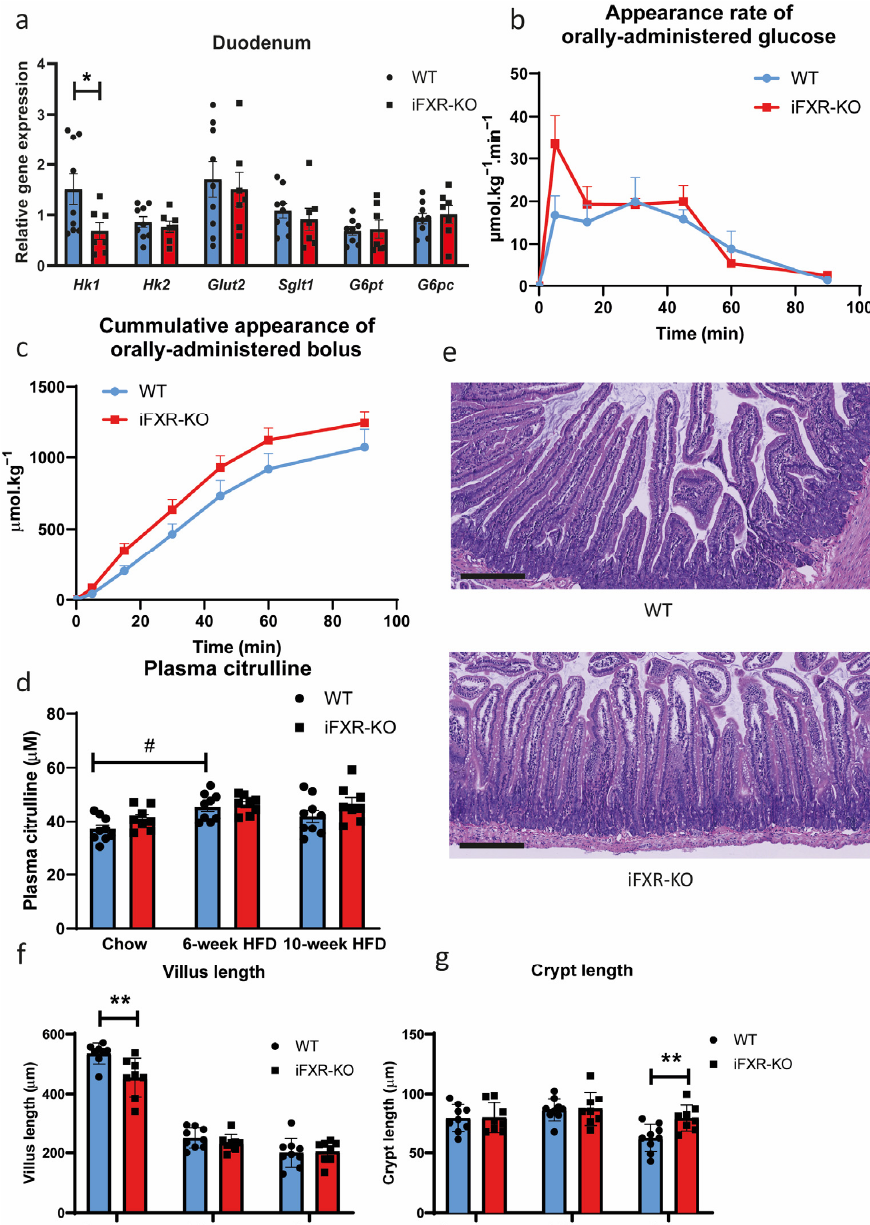
Figure 2. Long-term HFD exposure does not lead to changes of glucose absorption in iFXR-KO mice ( a ) Quantitative real-time PCR of glucose absorption gene expression in duodenum from wild-type (WT) and intestine-specific FXR − / − (iFXR-KO) mice after 10-week high-fat-diet (HFD); ( b ) Orally administrated D-[U- 13 C] glucose appearance rate and ( c ) recovery of orally administrated glucose bolus at 0, 5, 15, 30, 45, 60 and 90 min during glucose absorption test from WT and iFXR-KO mice after 10-week HFD; ( d ) Plasma citrulline level from WT and iFXR-KO mice when they were on chow diet, 6-week HFD and 10-week HFD; ( e ) Representative image of H&E staining of duodenum from WT and iFXR-KO mice after 10-week HFD (magnification 10×; bar represents 200 μ m); ( f ) Quantified analysis of villus length and ( g ) crypt length of duodenum, jejunum and ileum from WT and iFXR-KO mice after 10-week HFD (10 villi were selected from each mouse for qualification). Statistical significance was determined using the Mann–Whitney test in WT and iFXR-KO mice. All panels: n = 8–9/group, data are represented as mean ± SEM, panels ( a , f , g ): * p < 0.05 and ** p < 0.01 when iFXR-KO mice compared with WT mice; panel ( d ): # p < 0.05 when WT mice on chow condition compared with HFD condition.